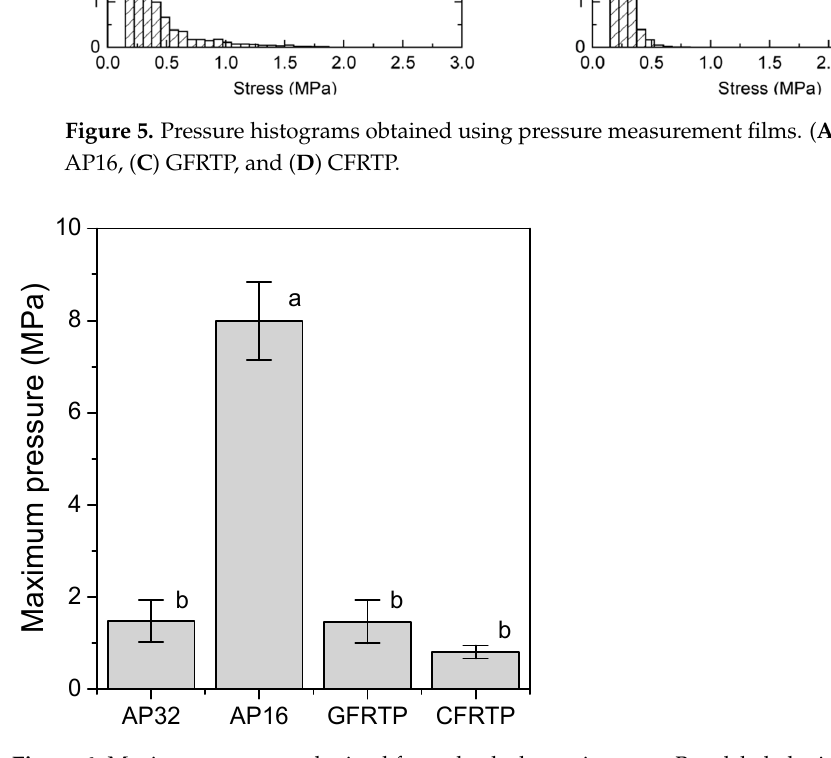
Figure 6. Maximum pressure obtained from shock absorption tests. Bars labeled with the same letter show no significant difference ( p > 0.05).